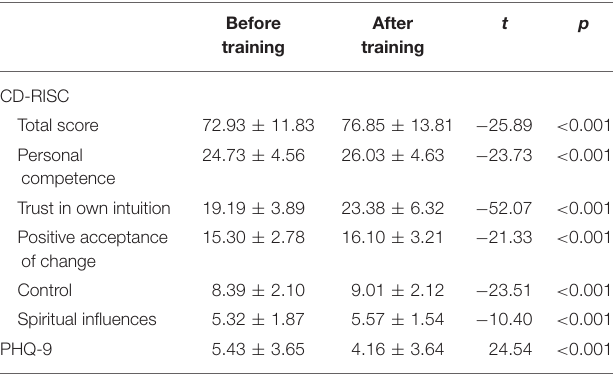
TABLE 1 | Comparisons of scores of the CD-RISC and PHQ-9 before and after military-style training. Before